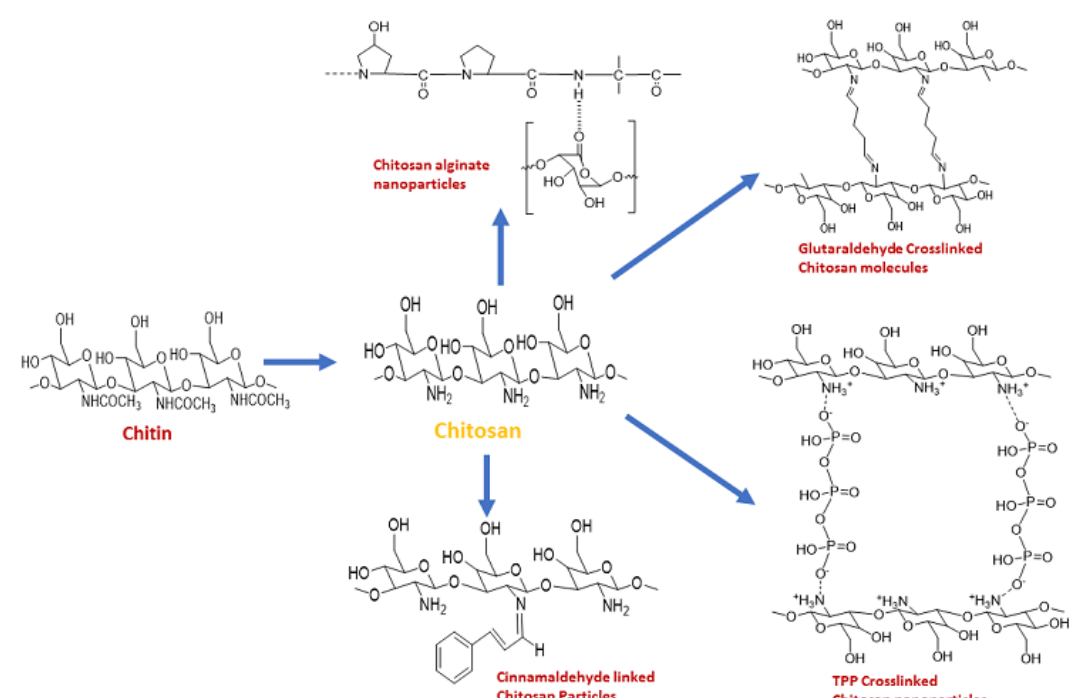
Figure 2. Different types of crosslinked chitosan.